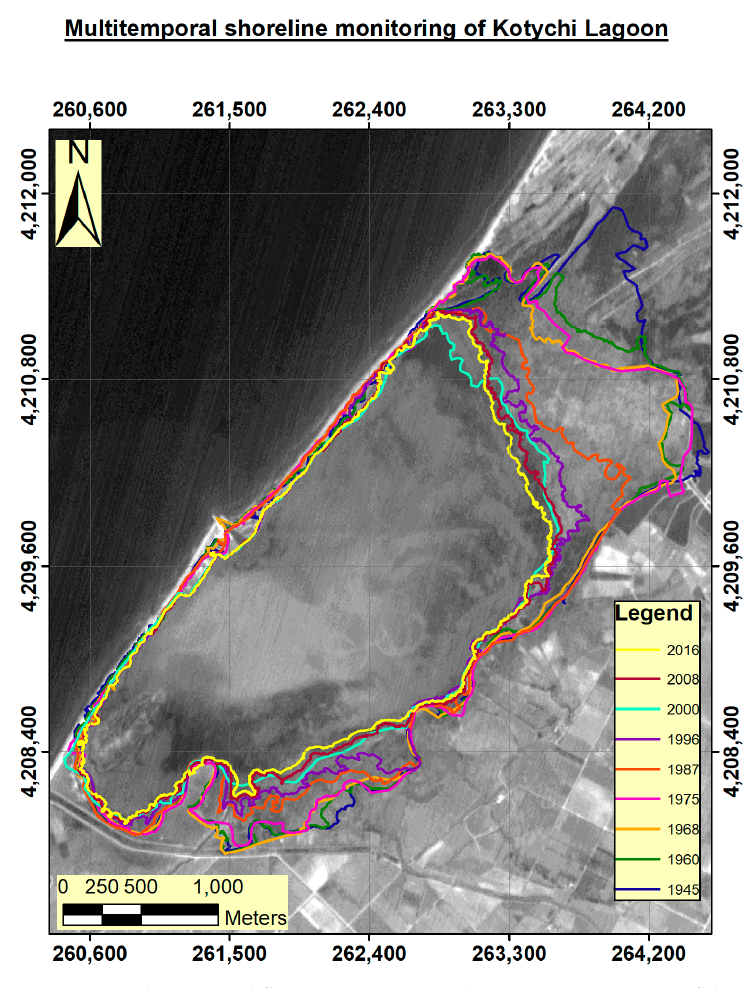
Figure 3. Multitemporal fluctuations in Kotychi Lagoon. Base map of the year 2000.